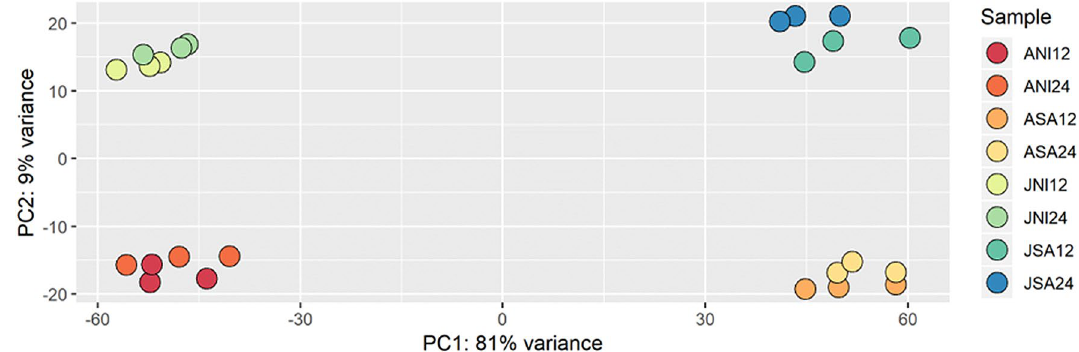
Figure 1. PCA plot shows distinct clusters of SAA infested and non-infested M. truncatula Jester and A17 samples. Principal component analysis of the 24 RNA sequencing samples exposes clustering of the three biological repeats per treatment and genotype. The infested (-SA) and non-infested (-NI) samples between two time-points (12 or 24) are grouped together. There was less variance between Jester infested (JSA12 and JSA 24) and A17 infested samples (ASA12 and ASA24) compared to their non-infested counterparts JNI12, JNI24 and ANI12, ANI24